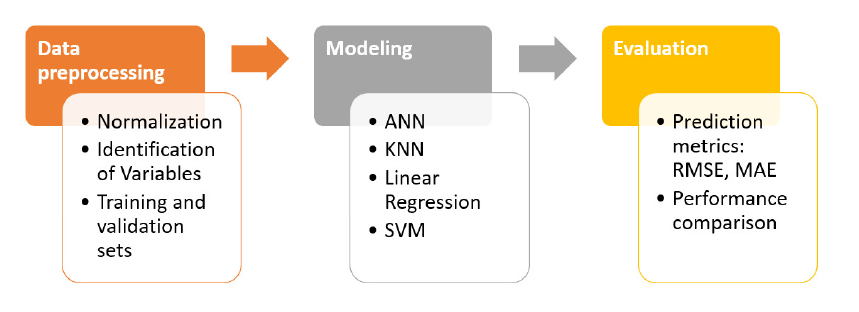
Figure 3. Framework of the proposed